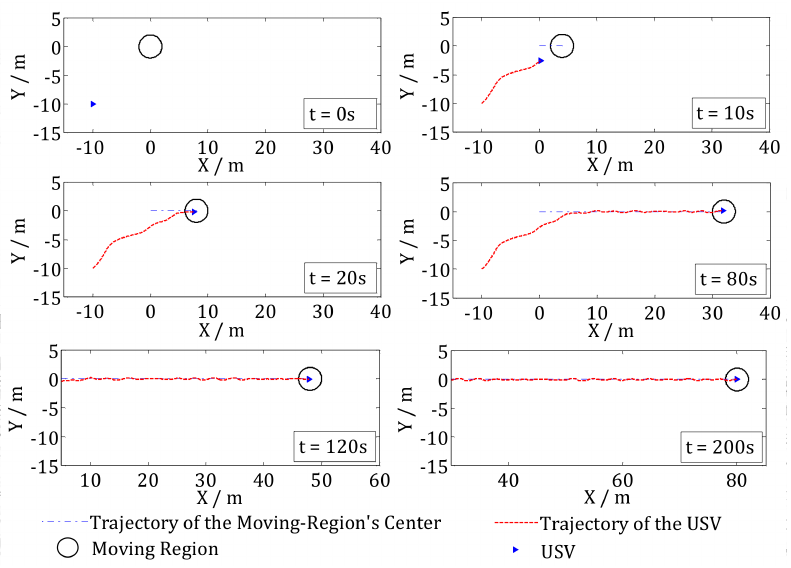
Figure 16. Trajectory tracking results under the NTTC method.